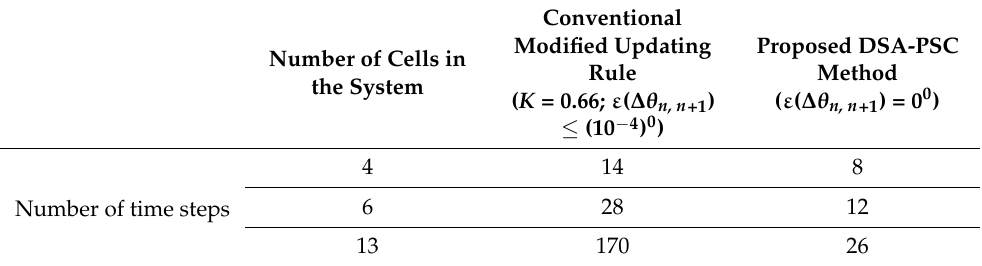
Table 5. Evaluate the system configuration time.